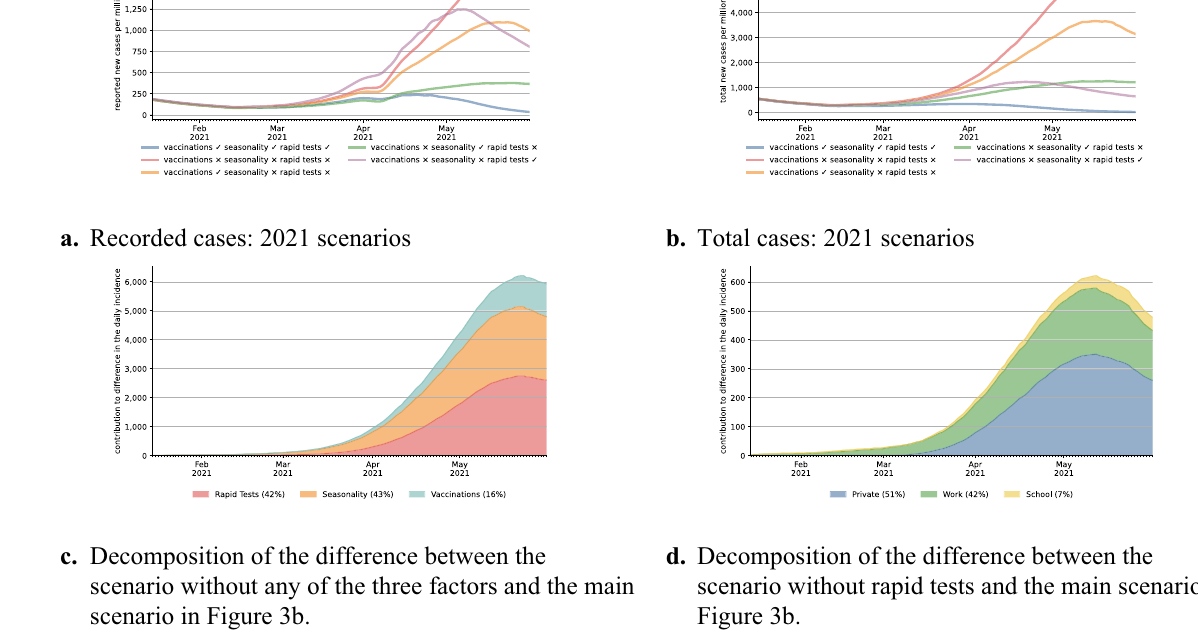
Figure 3. The effect of different interventions on recorded and actual infections. The blue line in ( a ) is the same as in ( a ) and refers to our baseline scenario, so does the blue line in ( b ). The red lines refer to a situation where NPIs evolve as in the baseline scenario and the B.1.1.7 variant is introduced in the same way; vaccinations, rapid tests, and seasonality remain at their January levels. The other scenarios turn each of these three factors on individually. The decompositions in ( c , d ) are based on Shapley values, which are explained more thoroughly in Appendix A.10. For legibility reasons, all lines are rolling 7-day